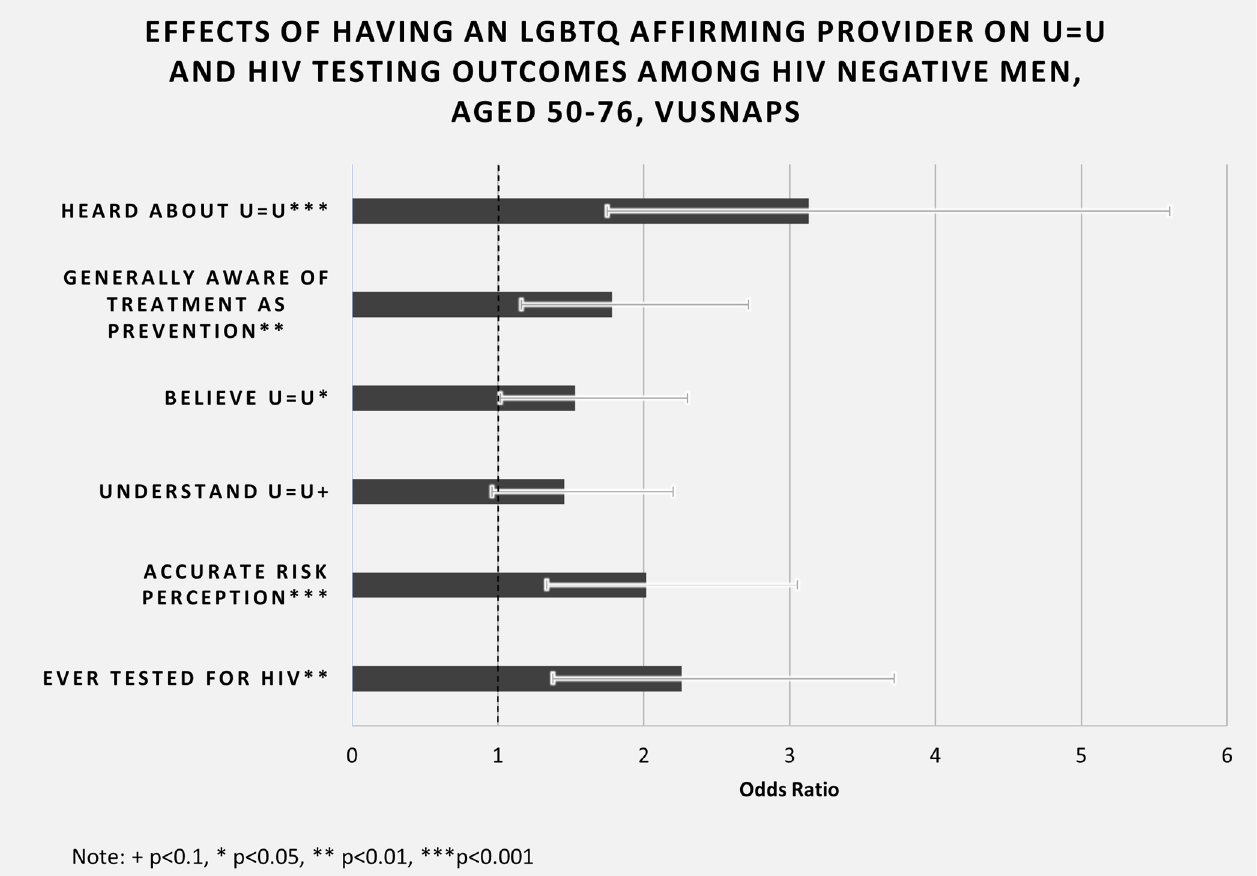
Figure 1. Effects of having an LGBTQ affirming provider on U = U and HIV testing outcomes among HIV negative men, aged 50–76, VUSNAPS. Note: Adjusted odds ratios are presented for HIV negative men only from the analyses presented in Tables 2 and 4–7. Analyses control for state of residence, age, education, race/ethnicity, partner status, ever tested for HIV (except for models where this is the outcome), and ever heard of U = U (except for models where this is the outcome). All odds ratios are significant at the p < 0.05 level or higher, except “Understand U = U”, which is significant at the p < 0.1